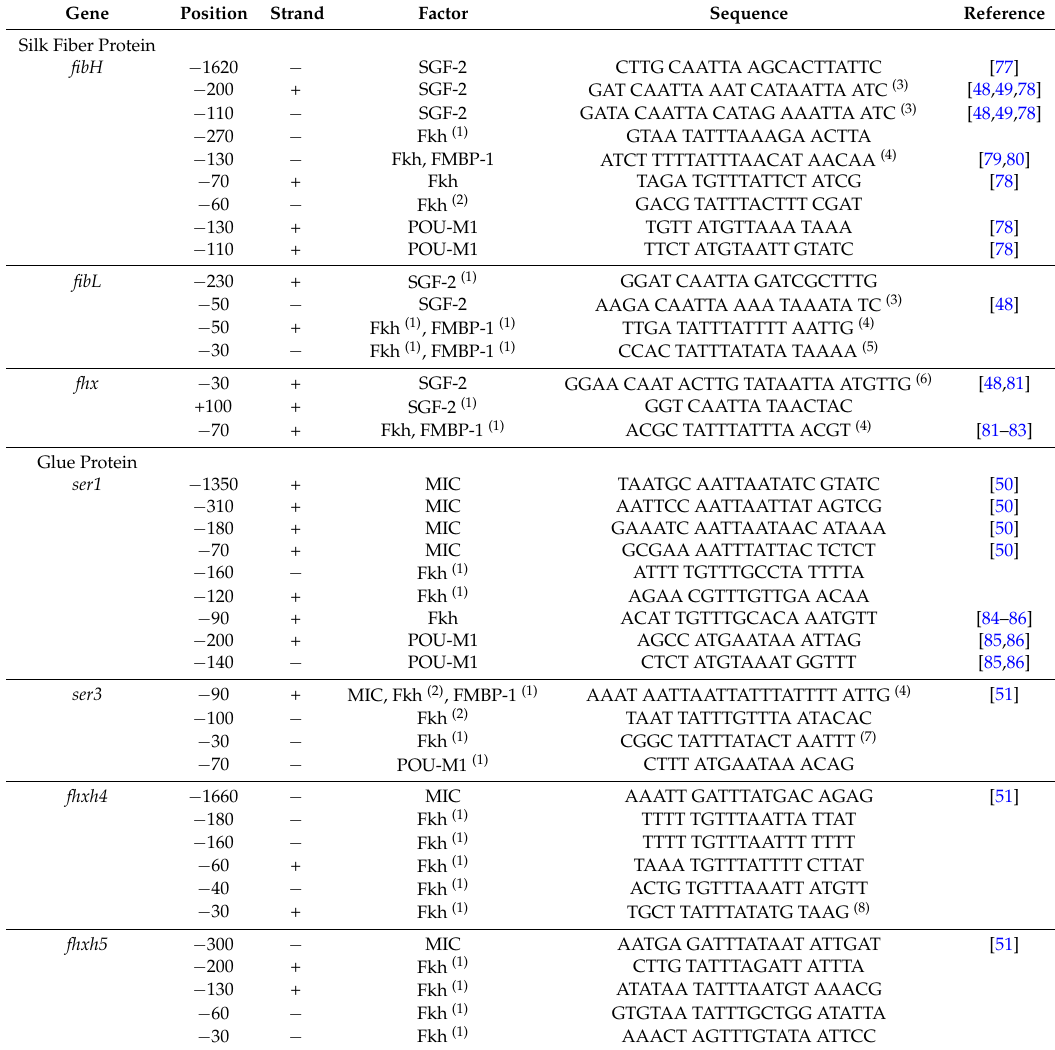
Table 2. Nucleotide sequence around the regulatory elements of the silk gene promoter. Gene Position